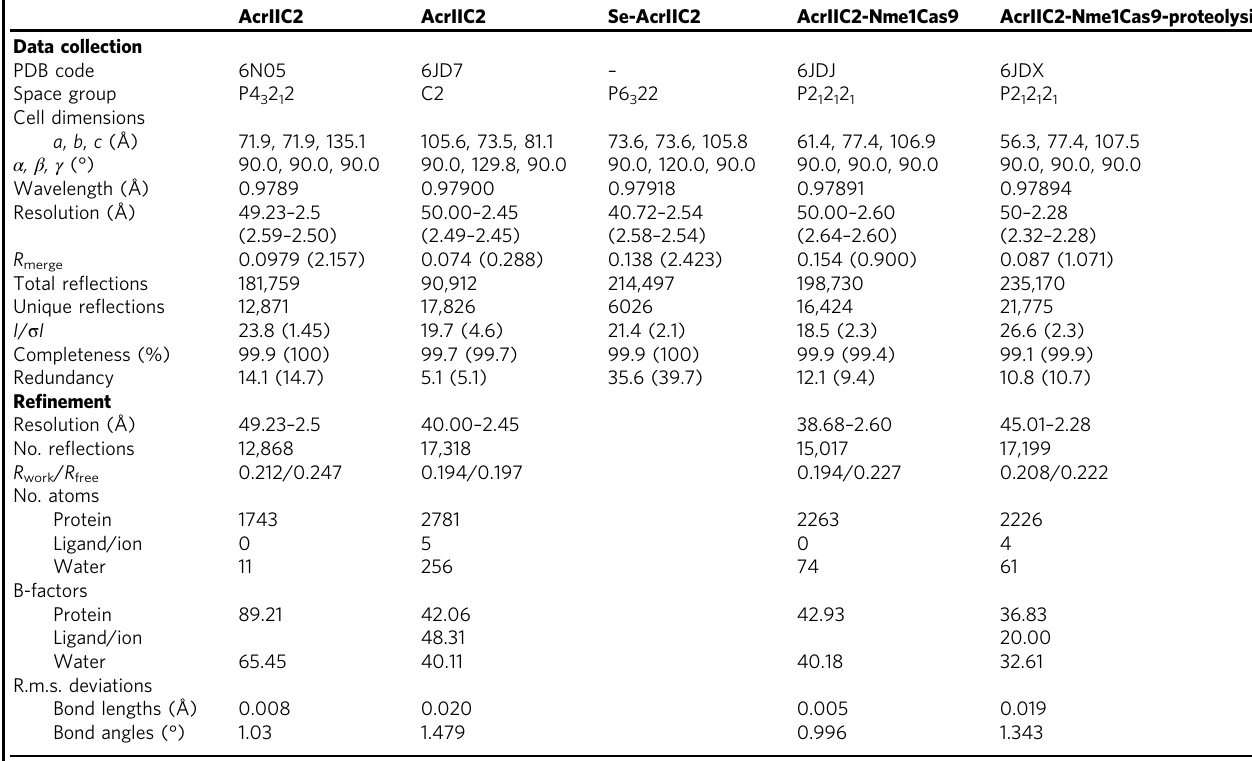
Table 1 Data collection and re fi nement statistics